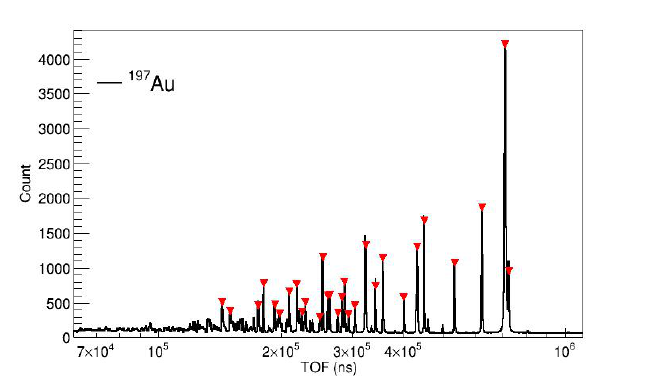
Fig.9 The TOF spectrum of the 197 Au